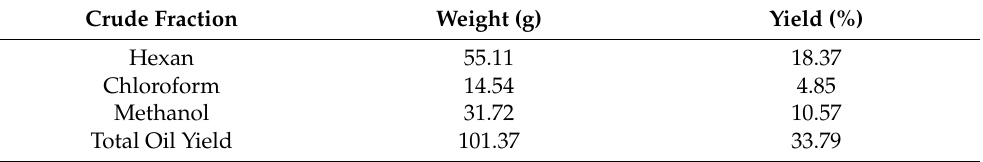
Table 1. Percentage (%) yield of the different crude fractions extracts from Azadirachta indica seed.